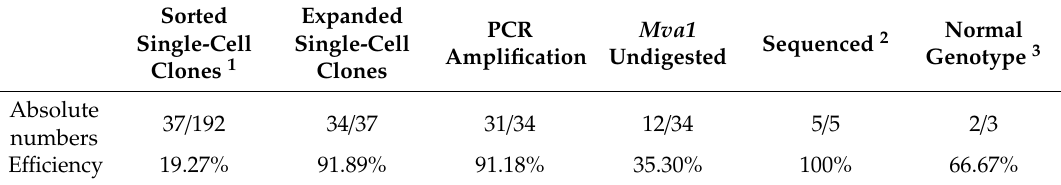
Table 2. The summary of each stage of the gene-corrected p.A30P SNCA single-cell isogenic cell lines